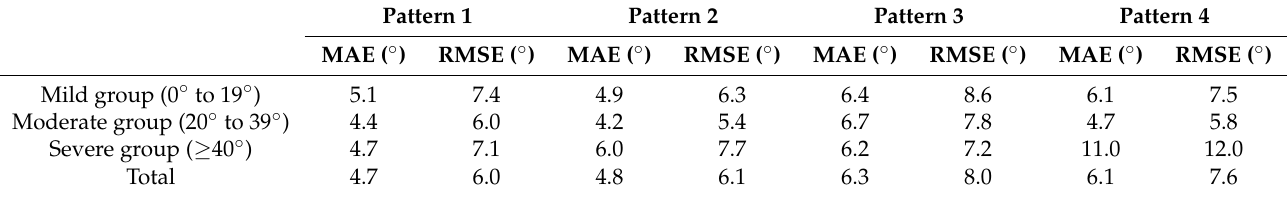
MAE = Mean absolute error, RMSE = Root mean square